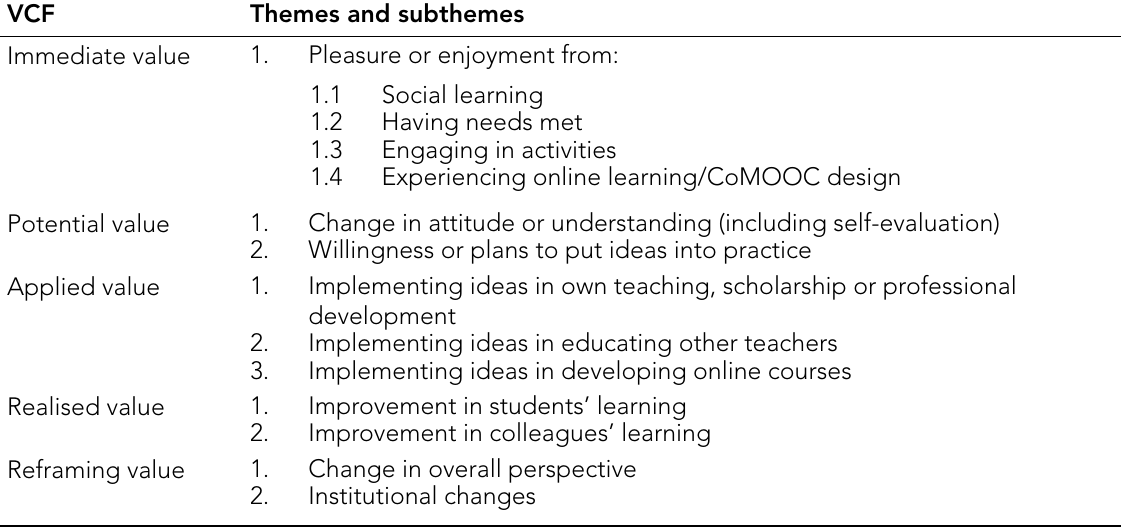
Table 2. Themes relating to the value creation framework across the interview and survey data sets (Source: Authors,